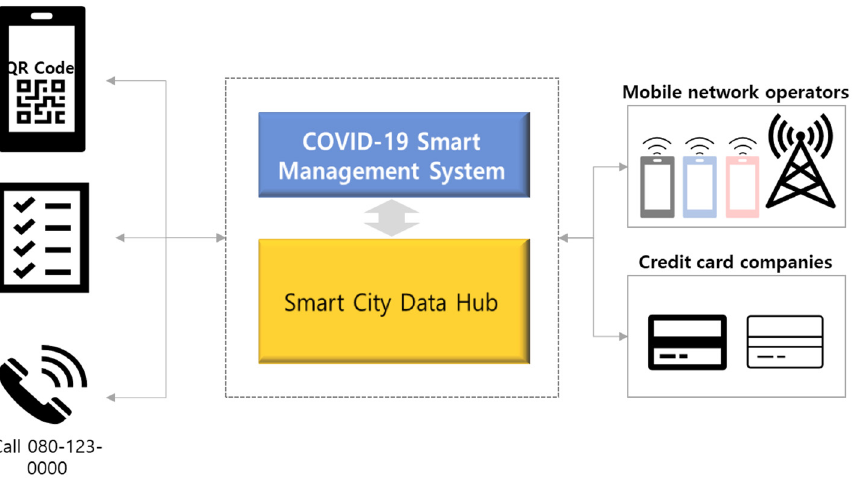
Figure 1. Korea’s COVID-19 smart management system (SMS).